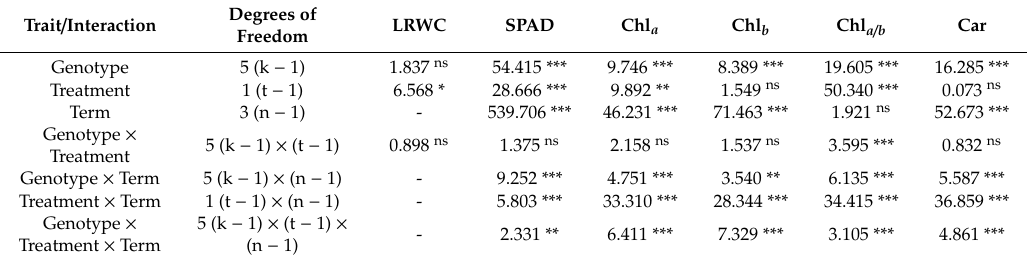
genotypes (OMA lines and cv. Bingo).